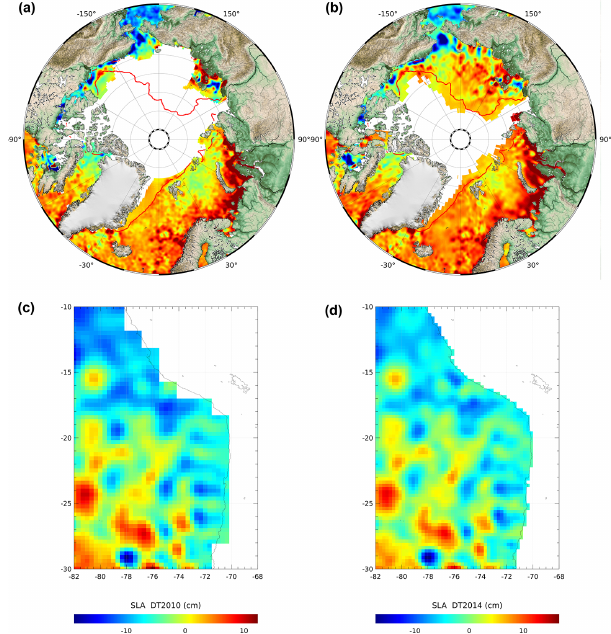
Figure 13. Coverage improvement associated with the DT2014 re- processing. Map of SLA for day 2011/10/17 over the Arctic Ocean observed with the DT2010 (a) and DT2014 (b) products. Sea ice ex- tent is shown with red line (OSISAF product). Same map along the western South American coast with DT2010 (c) and DT2014 (d)